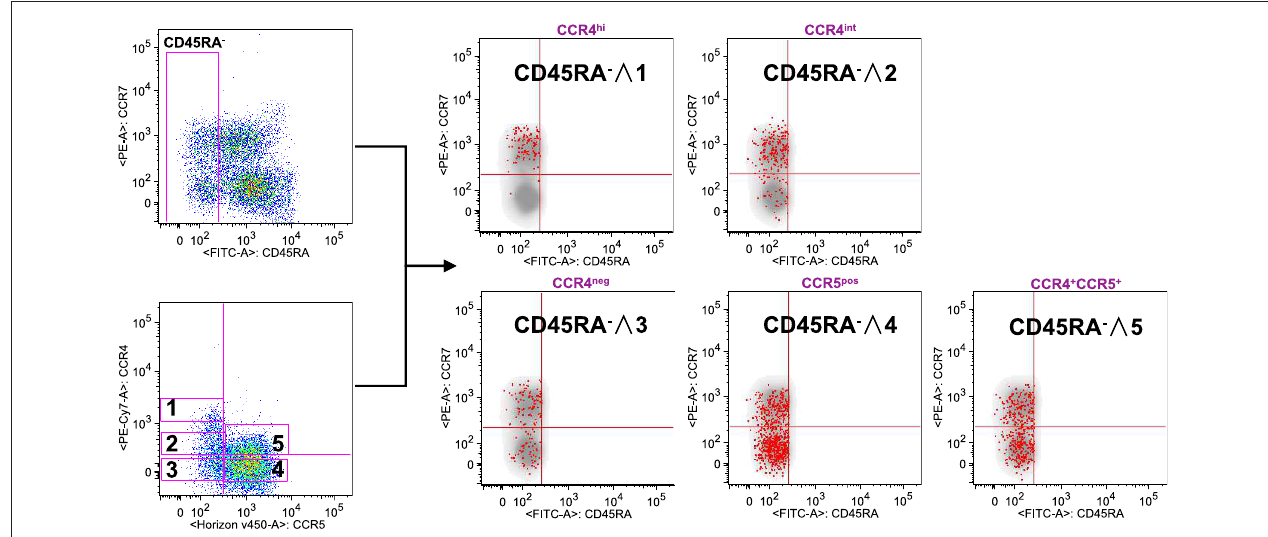
FIGURE 2 | CCR4 expression characterizes the T CM compartment. PBMCs isolated from healthy control subjects were stained for CD8, memory T cell phenotype markers (CD45RA and CCR7) and for chemokine receptors CCR4 and CCR5. (A) CD8 + T cells were analyzed for the memory phenotype according to CD45RA, CCR7 expression and for the expression of the chemokine receptors CCR4 and CCR5. On the basis of the chemokine receptor expression we identified five subsets CCR4 hi (gate 1), CCR4 int (gate 2), CCR4 − CCR5 − (gate 3), CCR4 − CCR5 + (gate 4) and CCR4 + CCR5 + (gate 5). These five subsets were superimposed to the density plot of the CD45RA − gated cells. Each red dot identifies cells from the corresponding subset as reported in the figure. The axis scales for fluorescence are reported as log.